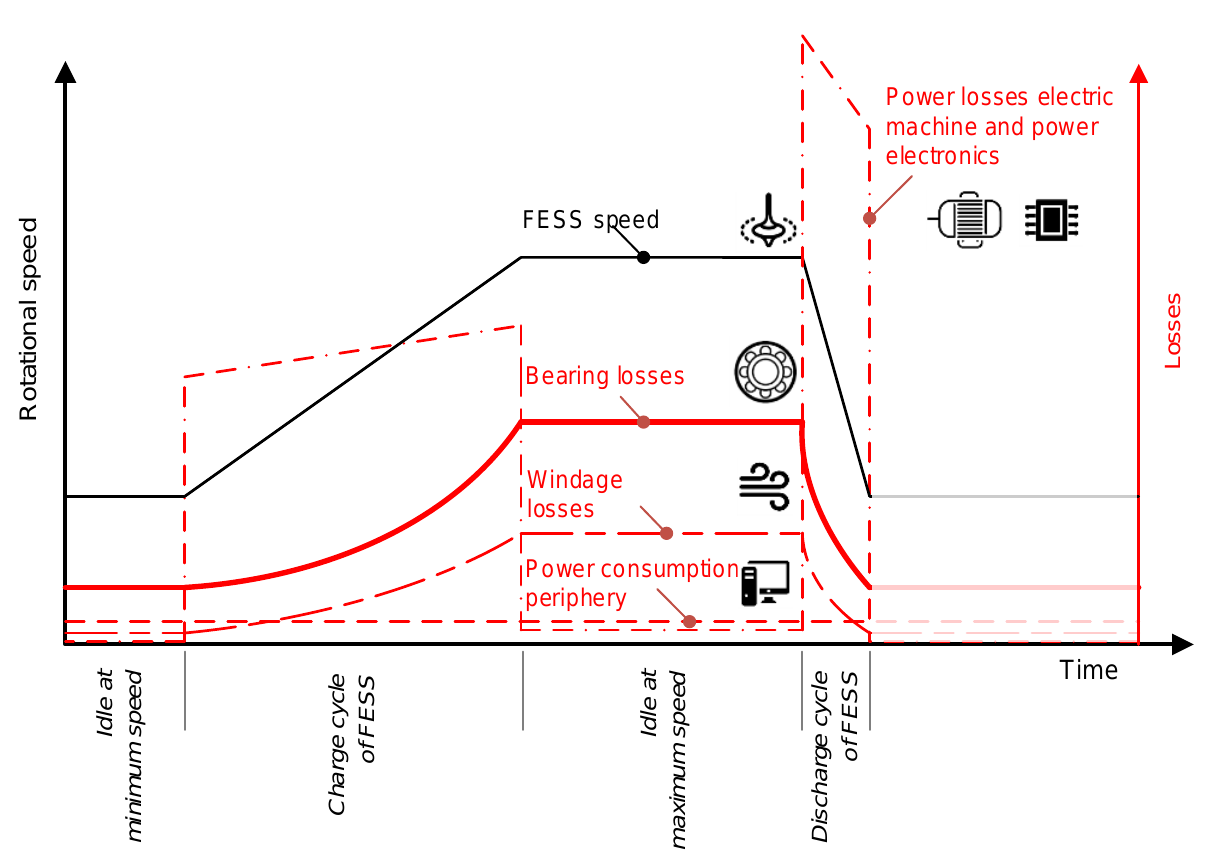
Figure 1. Losses in a FESS over a charge-/discharge cycle.